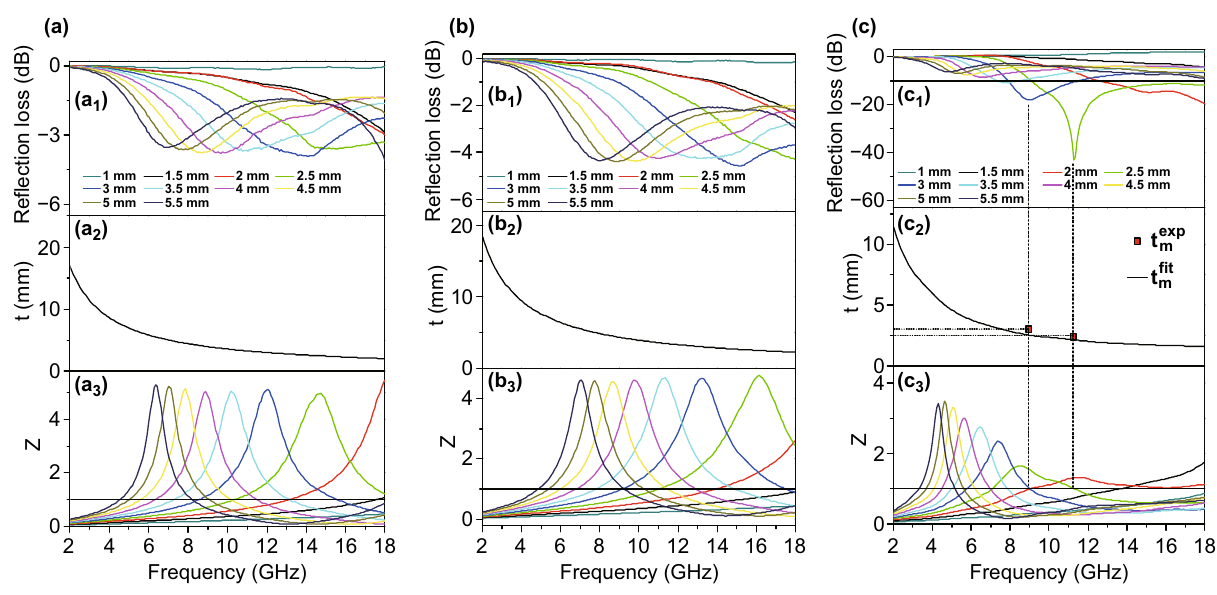
Fig. 10 Reflection loss ( a 1 – c 1 ), simulation of the matching thickness ( t m ) under n = 1 ( a 2 – c 2 ), the modulus of the normalized characteristic impedance matching (Z = |Z in /Z 0 |) ( a 3 – c 3 ) for Co/NC ( a ), Fe–Co/NC ( b ), and Fe–Co/NC/rGO ( c